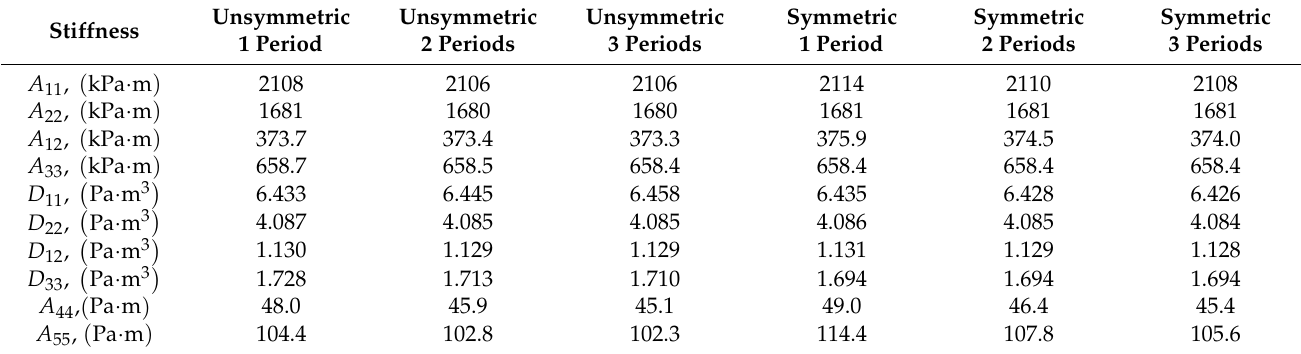
Figure 9. Different numbers of periods of corrugated cardboard for unsymmetric fluting cardboards: ( a ) 1, ( b ) 2, and ( c ) 3 periods; and symmetric fluting cardboards: ( d ) 1, ( e ) 2, and ( f ) 3 periods. Table 5. The stiffnesses of the representative shell element computed for different numbers of periods for unsymmetric and symmetric sine